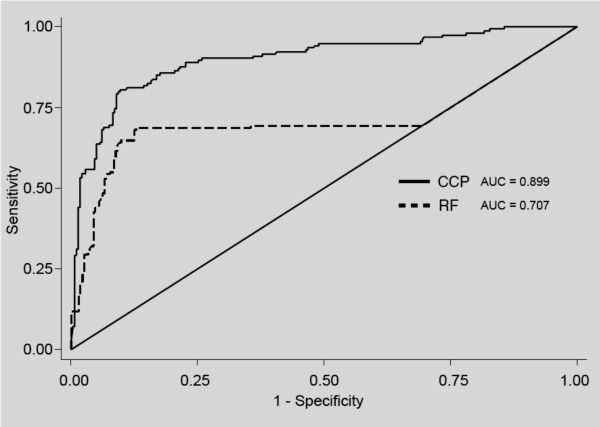
Receiver Operating Characteristic (ROC) curve of anti-CCP2 antibodies and rheumatoid factor.